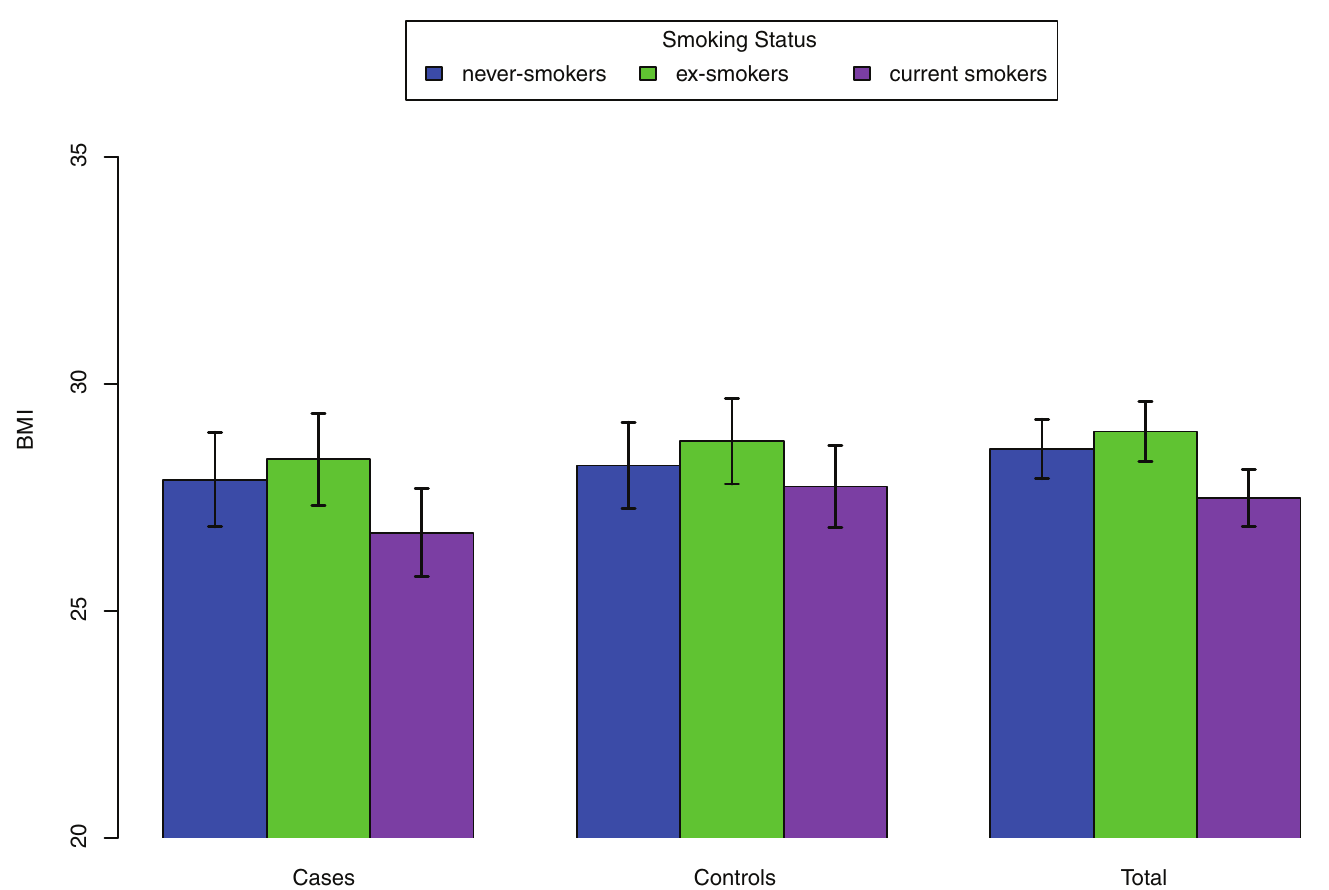
Fig 2. Adjusted means of BMI (95% CIs) for never-smokers, ex-smokers, and current smokerswith adjustment for age, sex, and study sites. Bar representsmean ± s.d.